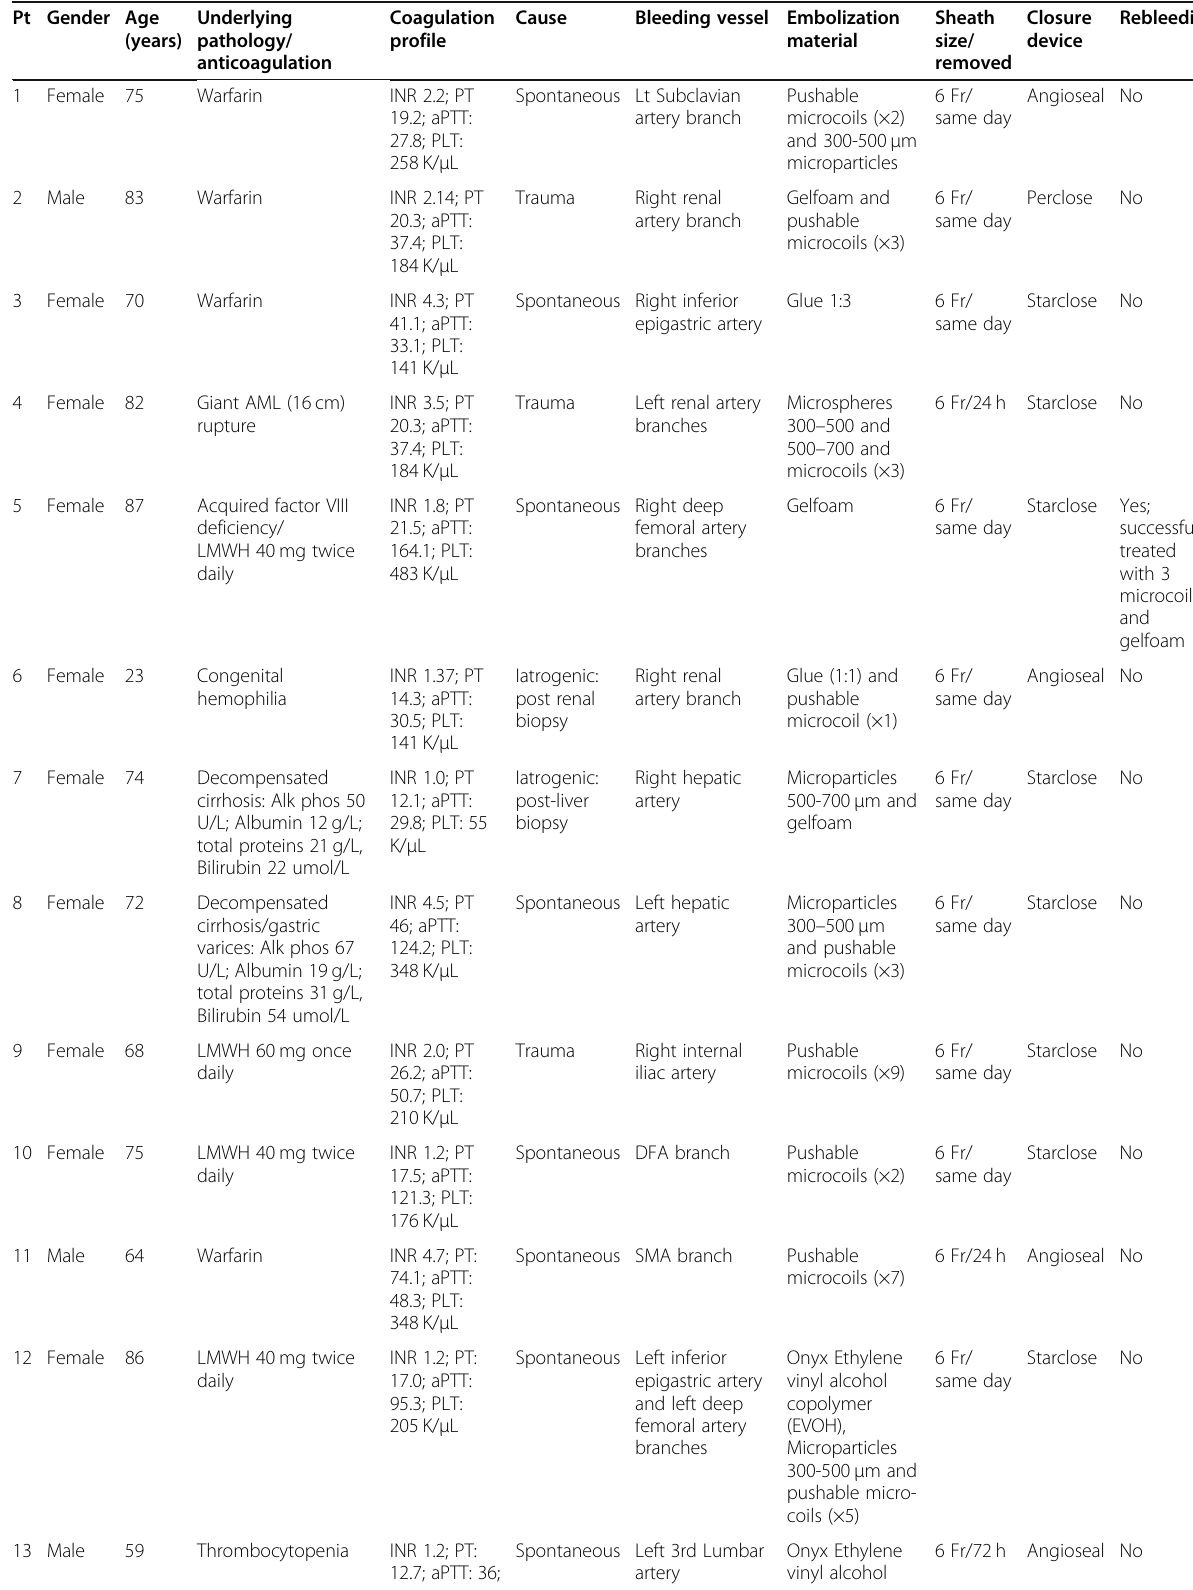
Table 1 Demographical data, coagulation data and procedural details Pt Gender Age Underlying (years)